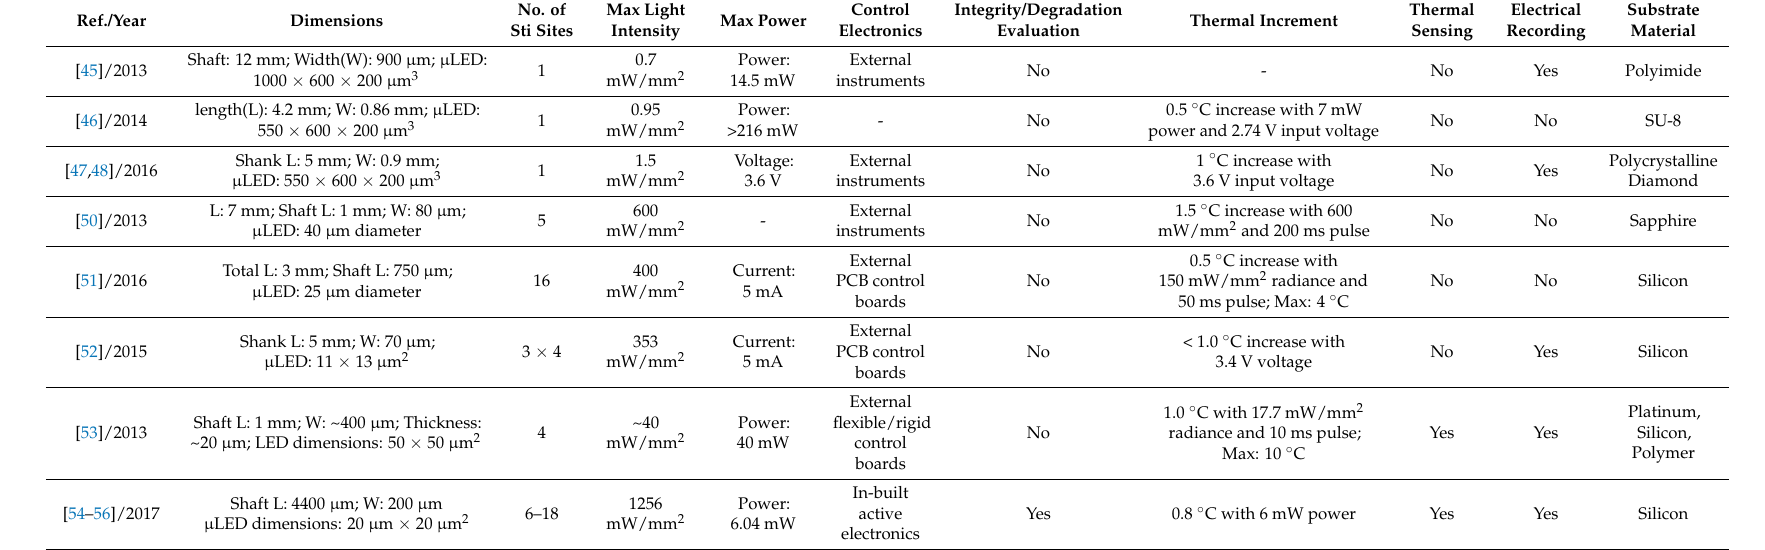
Table 2. Performance summary of recently published µ LED-on-optrode structure based optogenetic implants.